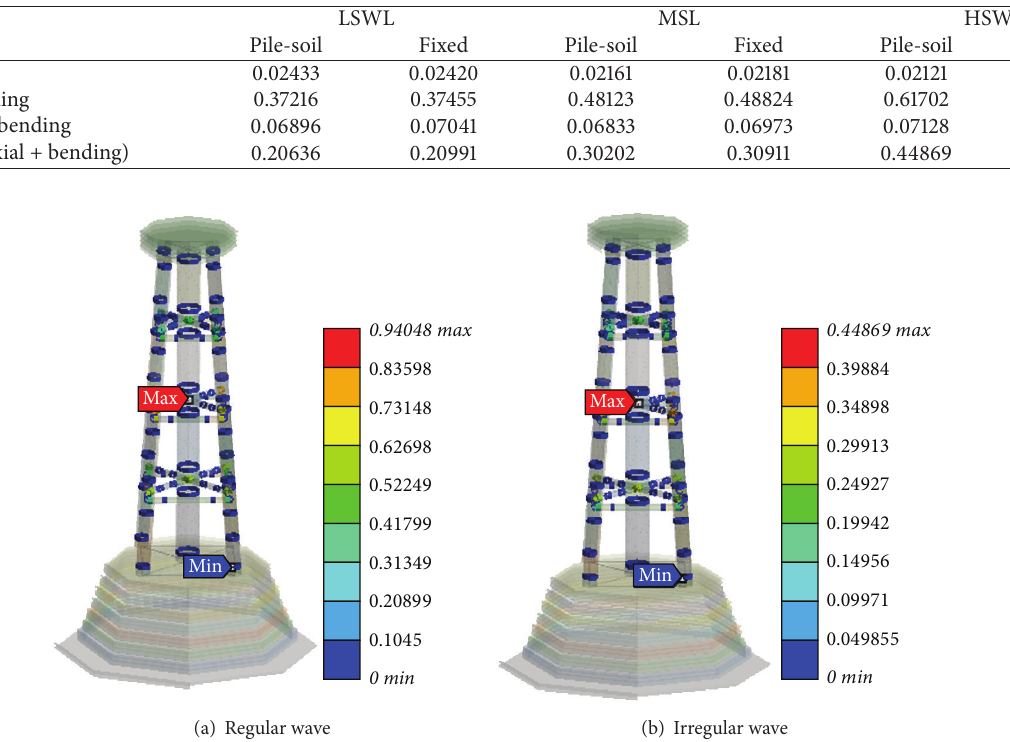
Figure 17: Joint unity checks for combined (axial + bending) at